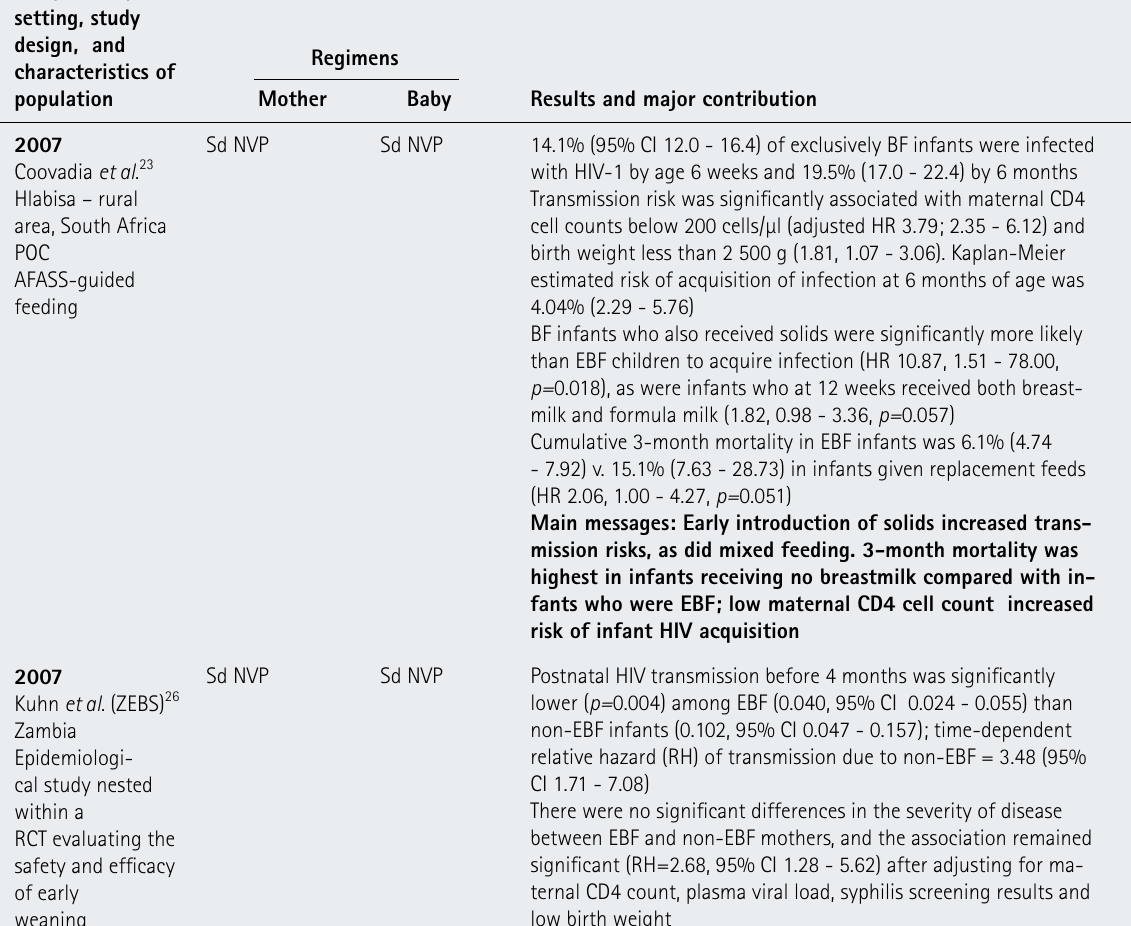
TABLE I. KEY STUDIES THAT HAVE CONTRIBUTED TO THE BODY OF KNOWLEDGE ON HIV AND INFANT FEEDING